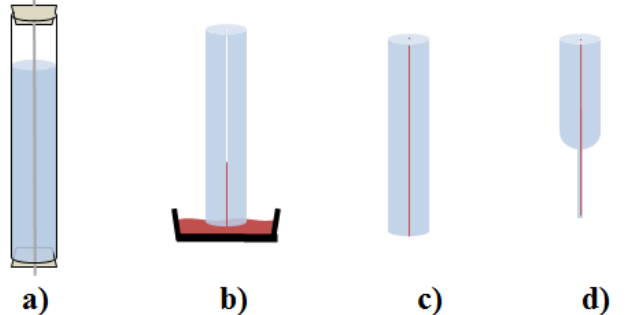
Figure 3. Schematic of core–shell preform production. ( a ) Fabrication of hollow-core PMMA preform. ( b ) Filling in the doped CHMA:MMA core material. ( c ) Polymerization process. ( d ) Near-single mode (SM) fiber is achieved by fiber drawing